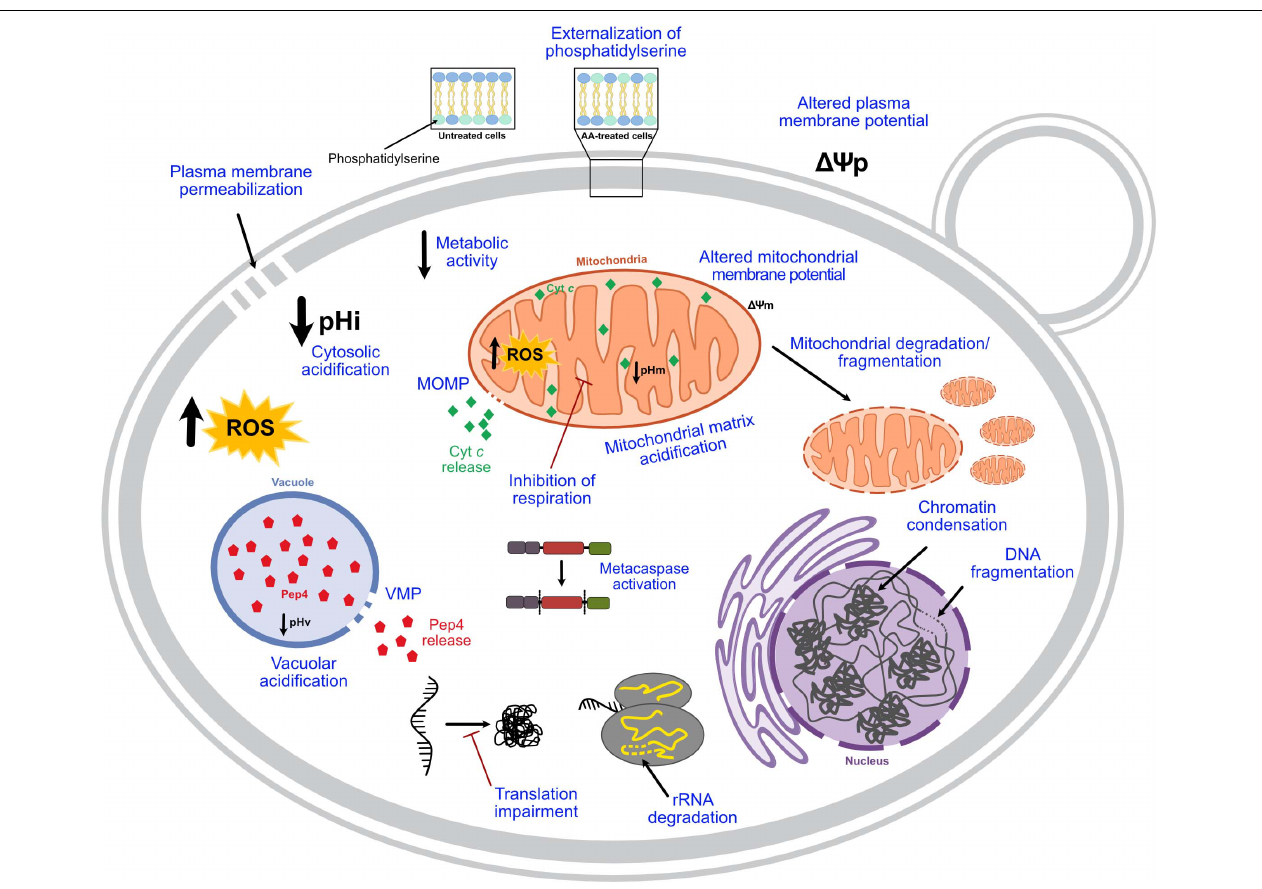
FIGURE 1 | Current knowledge on the hallmarks of AA-RCD. When yeast cells are treated with lethal concentrations of acetic acid, a regulated cell death process characterized by typical mammalian apoptotic markers, highlighted in blue, can be triggered depending on the concentration. pHi, intracellular pH; pHv, vacuolar pH; pHm, mitochondrial pH; VMP, vacuolar membrane permeabilization; MOMP, mitochondrial outer membrane permeabilization; Cyt c , cytochrome c ; (cid:57) p, plasma membrane potential; (cid:57) m, mitochondrial membrane